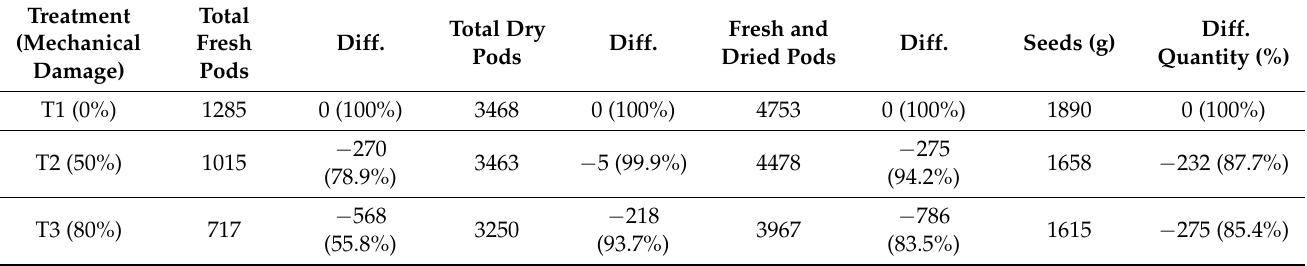
Table 2. Yield of total pods and seeds of Tepary bean ( Phaseolus acutifolius ) by treatment.